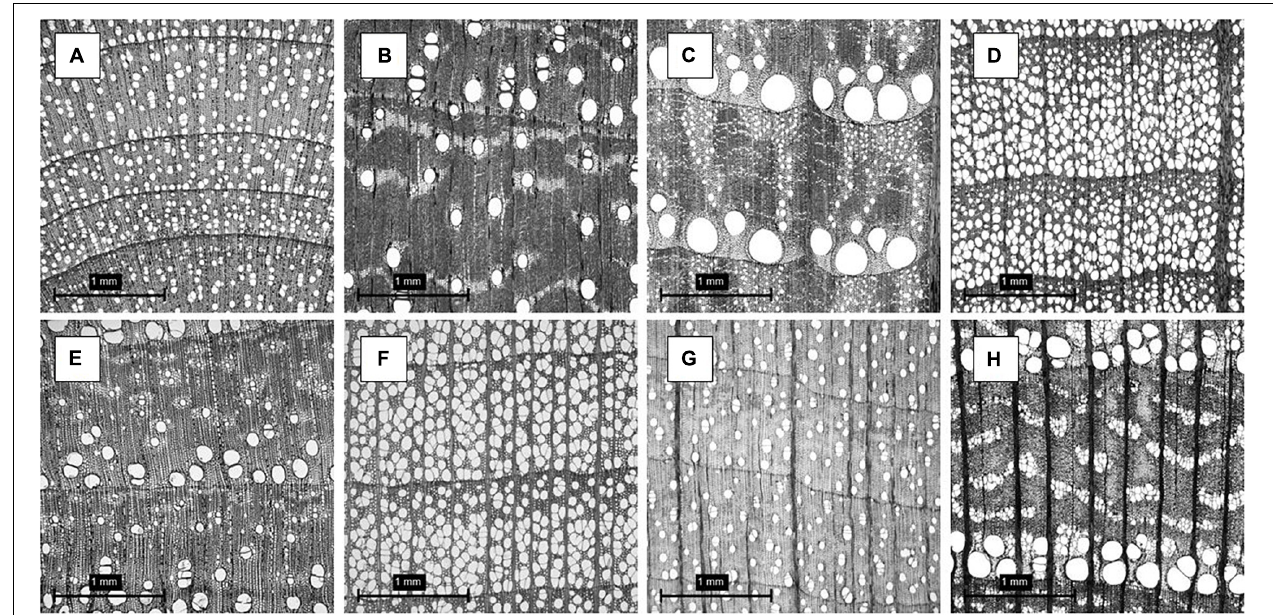
FIGURE 1 | (A) Betulaceae - Alnus firma ; (B) Cannabaceae - Aphananthe aspera ; (C) Fagaceae - Quercus crispula ; (D) Fagaceae - Fagus japonica ; (E) Lauraceae - Sassafras tzumu ; (F) Magnoliaceae - Liriodendron tulipifera ; (G) Sapindaceae - Acer distylum ; (H) Ulmaceae - Ulmus laciniata . Refer to the dataset for full dataset